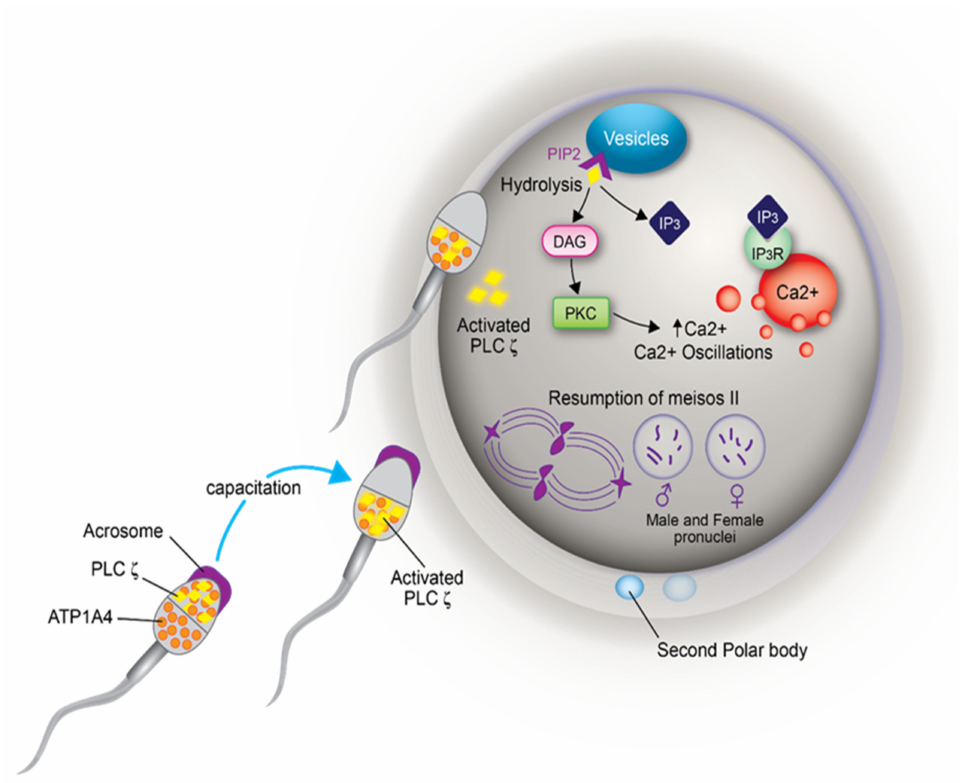
Figure 3. A hypothetical model depicting the involvement of ATP1A4 (Na/K-ATPase α 4) mediated activation of PLC ζ (phospholipase C zeta) and the involvement of activated PLC ζ in oocyte activation. In fresh sperm, ATP1A4 is localized to the entire sperm head and PLC ζ to the acrosomal region. In capacitated sperm, both proteins are co-localized to the post-acrosomal region. The interaction of these two proteins during capacitation activates PLC ζ . Following sperm penetration, the equatorial segment of the sperm head fuses with the oolemma, resulting in the release of activated PLC ζ into the oocyte cytoplasm. This activated PLC ζ binds to PIP2 (phosphatidylinositol biphosphate) substrate, present in small vesicles inside the oocyte, resulting in its hydrolysis and formation of IP3 (inositol triphosphate) and DAG (diacyl glycerol). IP3 binds to its receptor in intracellular calcium reserves and releases calcium, thereby increasing intracellular calcium ion concentrations. In addition, DAG activates PKC (protein kinase C), which also increases calcium concentration resulting in calcium oscillation. This calcium oscillation results in resumption of meiosis of the metaphase II-arrested oocyte, expulsion of the second polar body and formation of a female pronucleus. Concurrently, sperm nuclear decondensation occurs, resulting in formation of the male pronucleus. Fusion of male and female pronuclei results in zygote